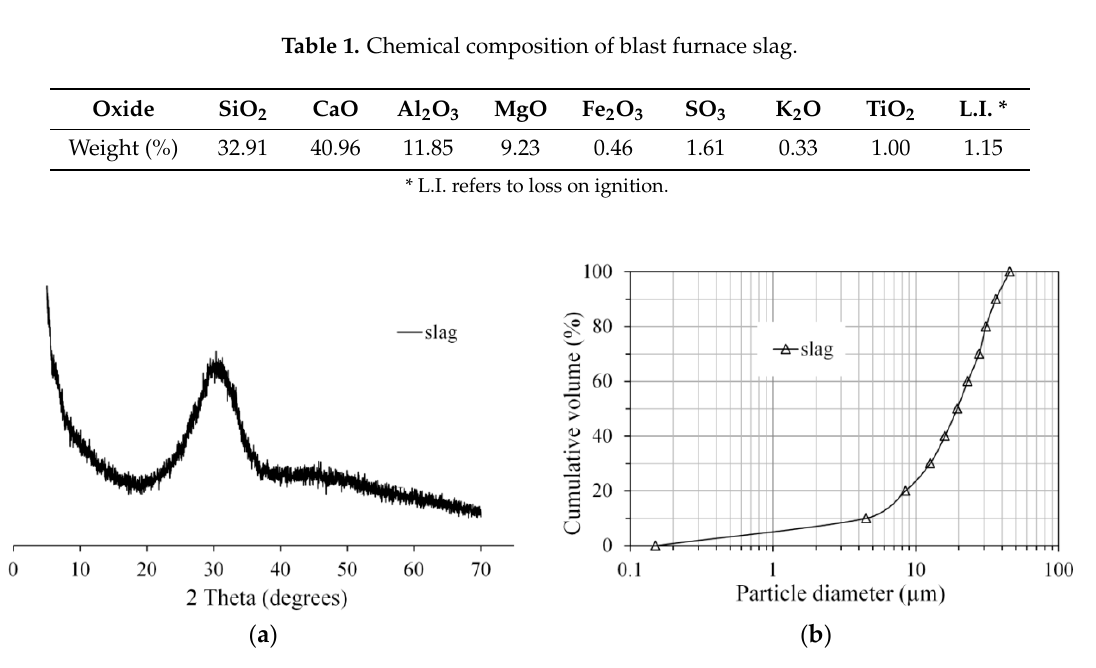
Figure 1. The X-ray diffraction pattern ( a ) and particle size distribution ( b ) of slag, determined by a powder diffractometer and laser diffraction respectively. Table 2. Mix composition of the alkali-activated slag pastes.